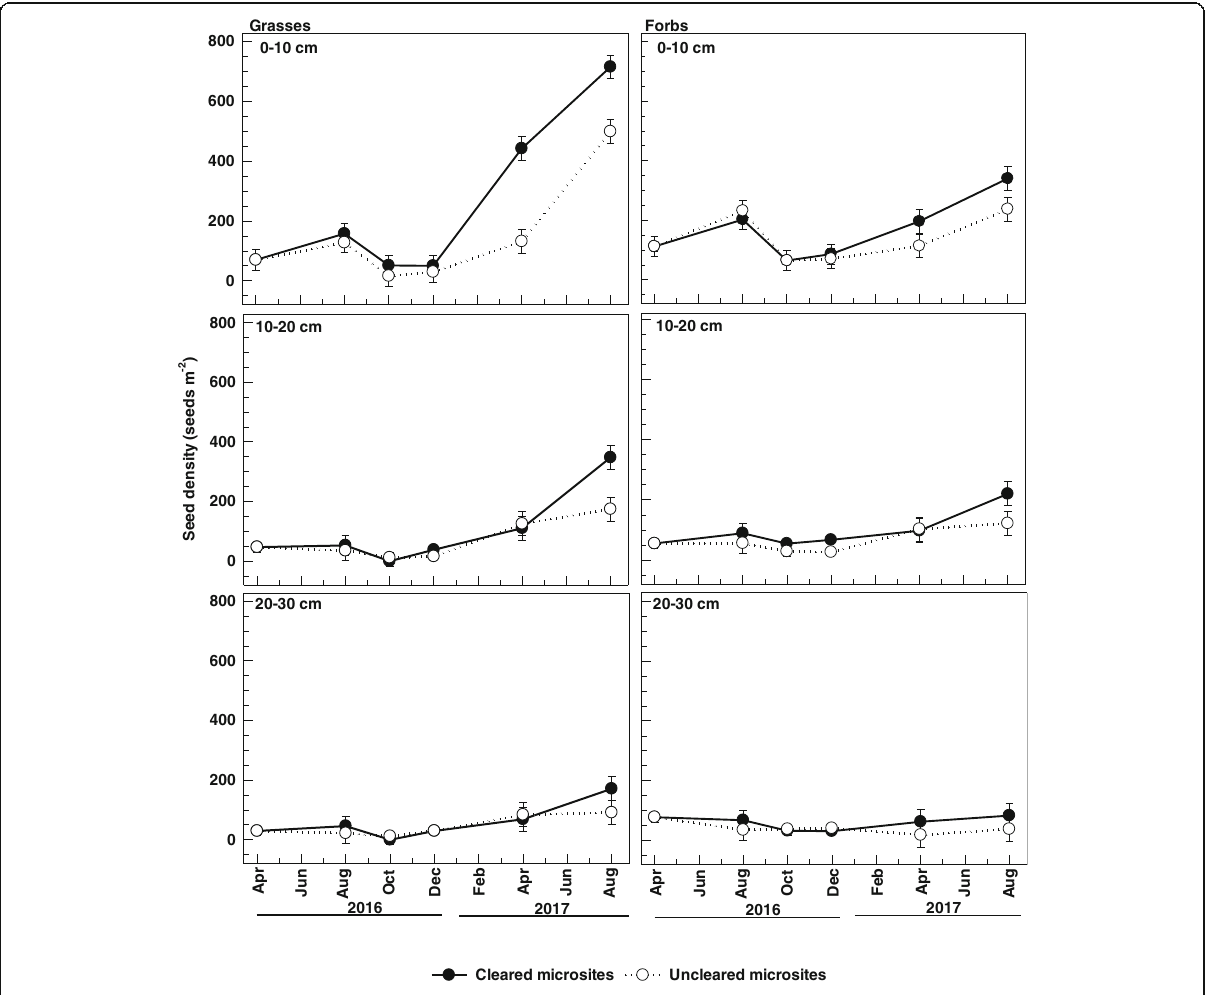
Fig. 2 Soil seed density of grasses and forbs in different soil depths in cleared and uncleared microsites at Maseding from April 2016 to August 2017. The presented data are back-transformed means and error bars represent ± standard error of mean. At Maseding, only grasses and forbs are presented because no sedges emerged from the SSB and the densities of shrubs, succulents, and legumes were very low (2 – 6 seeds m -2